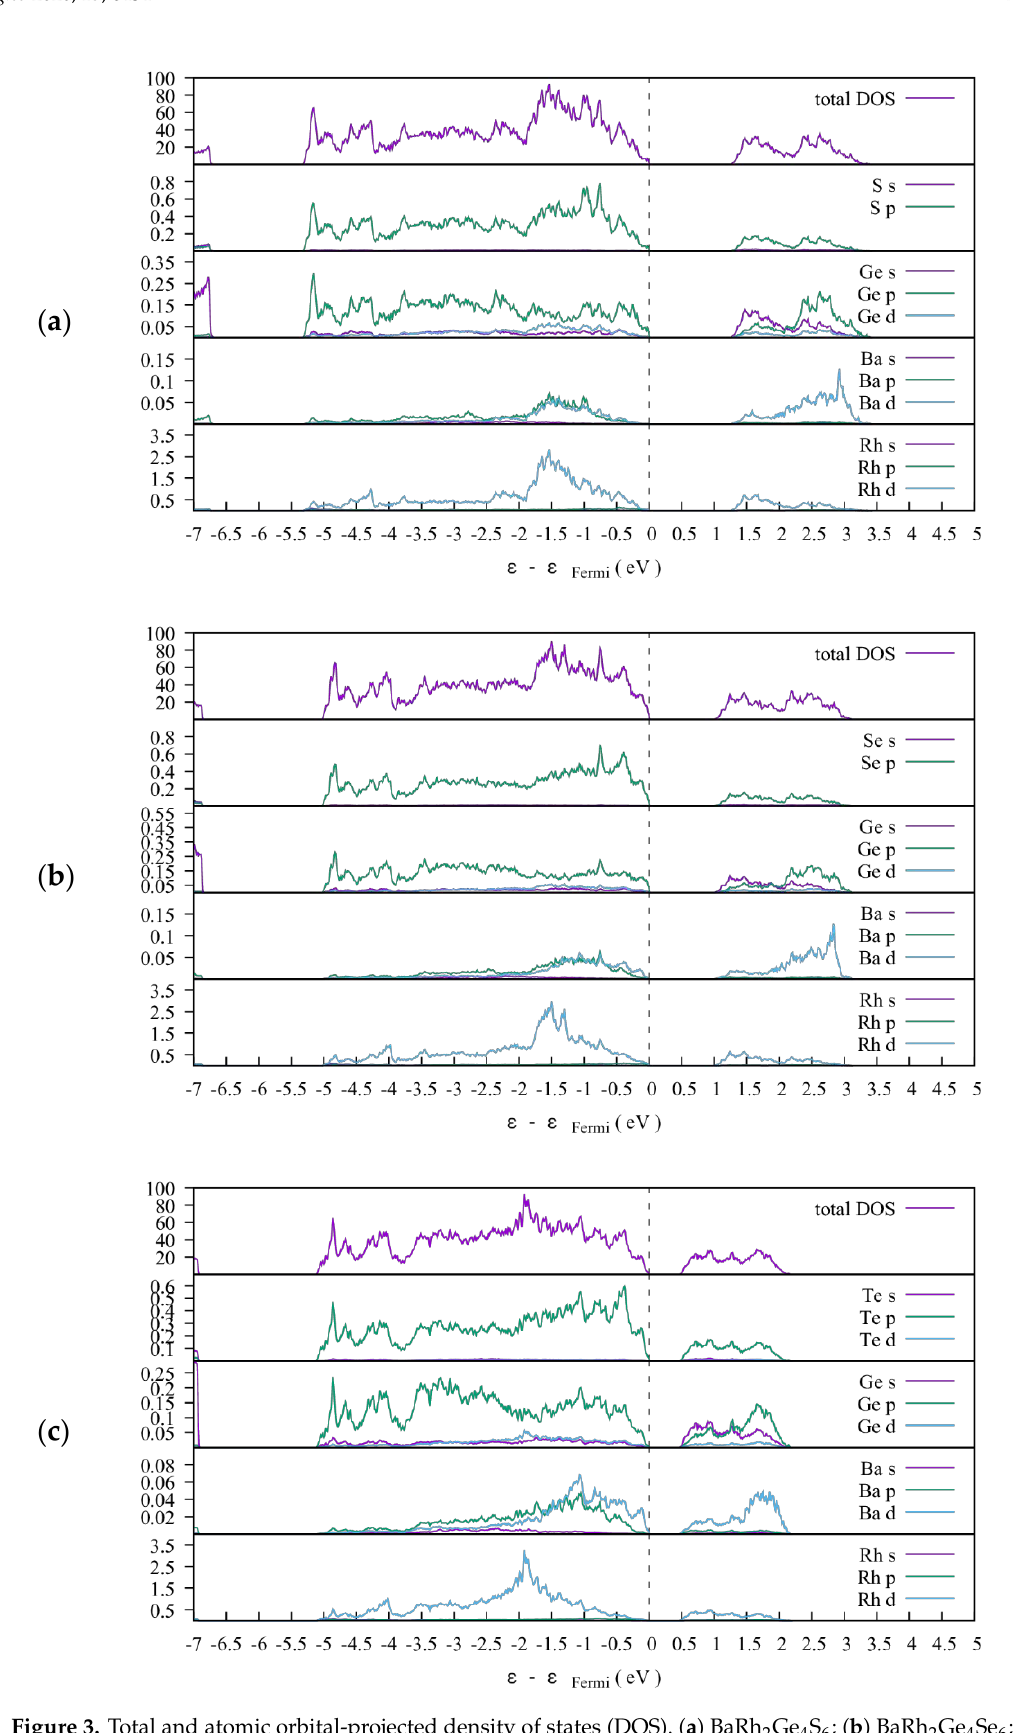
Figure 3. Total and atomic orbital-projected density of states (DOS). ( a ) BaRh 2 Ge 4 S 6 ; ( b ) BaRh 2 Ge 4 Se 6 ; ( c ) BaRh 2 Ge 4 Te 6 . The projected DOS are scaled by the number of corresponding atoms.